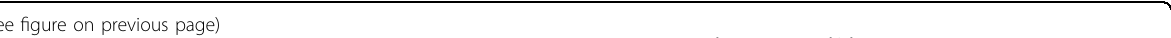
Fig. 3 Global transcriptomic analysis reveals that apoptotic signaling differs in EGFR low and EGFR high cells after BMP4 treatment. a Comparison of gene expression pro fi les between untreated (two replicates) and BMP4-treated (two replicates) cells. The left and right panels correspond to L0125 and L0615 glioma spheres. Each point on the plots corresponds to one gene. The X -axis shows the expression ratio (BMP4/UNT, log-scale). The Y -axis presents the corresponding adjusted P -values computed with DESeq, -log10 (adj. P -value). The Benjamini and Hochberg method was applied for the P -value adjustment. Genes whose expression levels were signi fi cantly altered (adj. P -value<0.05 and |log fold change | >2) are marked with colors – yellow for L0125 cells and purple for L0615 cells. The numbers of genes signi fi cantly down- or upregulated are written above the plots. b Venn diagrams summarizing the overlap between differentially up- (top) and downregulated (bottom) genes in the two different cell lines. Yellow and purple circles represent L0125 and L0625 cell lines, respectively. c Scatter plot comparing gene expression changes of signi fi cantly differentially expressed genes after BMP4 treatment. Each point on the plot corresponds to one gene. Only genes differentially expressed in at least one cell line are plotted. The X -axis and Y -axis correspond to expression changes in the L0125 and L0615 cell lines, respectively. The color magnitude represents the density of points. d Number of KEGG signaling pathways signi fi cantly enriched in the sets of differentially downregulated or upregulated genes. The bars on the left correspond to sets of upregulated genes, while the bars on the right correspond to sets of downregulated genes. Yellow and purple bars depict results speci fi c for the L0125 and L0615 cell lines, respectively. Light purple bars (second and fi fth from the left) show a number of nonspeci fi cally enriched pathways. e All KEGG pathways enriched in sets of genes signi fi cantly downregulated after BMP4 treatment. The top and bottom panels correspond to the L0125 and L0615 cell lines, respectively. X -axes on both plots represent Benjamini and Hochberg adjusted P -values. The red lines mark P -values = 0.05. f Signi fi cantly enriched signaling pathways in sets of upregulated genes upon BMP4 treatment. Yellow and purple bars depict results speci fi c for the L0125 and L0615 cell lines, respectively. Names of pathways speci fi cally enriched for either L0125 or L0615 cells are marked with rectangles. The bars represent relative enrichment (see methods for details). Signaling pathway de fi nitions were obtained from the KEGG database. g Top transcription factors for which binding motifs in promoters of BMP4 upregulated genes were identi fi ed. Yellow and purple bars indicate the results for the L0125 and L0615 cell lines, respectively. The lengths of the bars represent log-odds difference of computed scores for the analyzed motifs. The analysis was performed using the Molecular Signatures Database. h A heatmap represents average expression changes of genes involved in apoptosis and differentially expressed after BMP4 treatment in at least one cell line. The z -scores were computed separately for the two cell lines and used to compute the average values (two replicates per average). The fi rst two columns (from the left) correspond to the L0125 line, and the last two correspond to the L0615 line. The rows were clustered using an unsupervised method. i Networks visualizing signaling pathways enriched in a set of genes differentially regulated between BMP4-treated L0125 and L0615 cell lines. The pale yellow points depict identi fi ed pathways. Green and red dots represent genes with signi fi cantly higher expression levels in L0125 + BMP4 and L0615 + BMP4 cells, respectively. The gray lines represent genes that are members of a particular